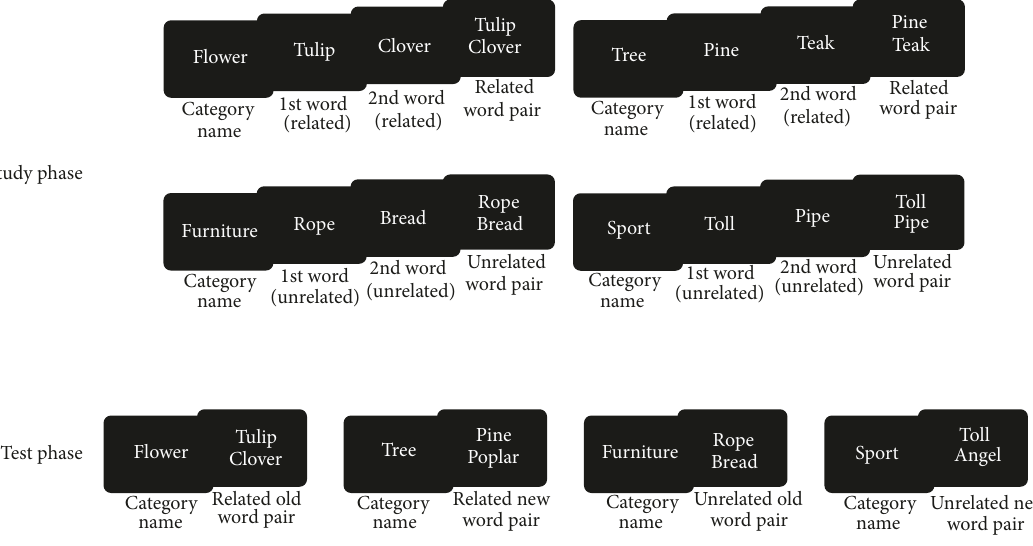
Figure 1: Examples of stimuli during the study and test